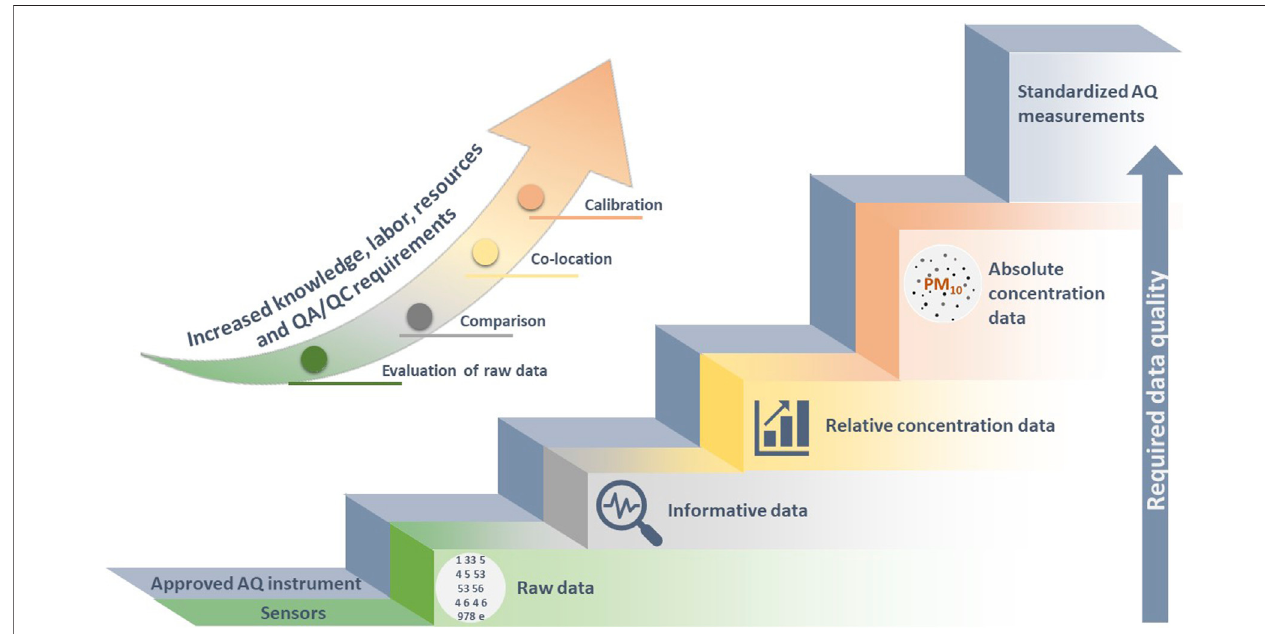
FIGURE2| Schematic ofthe QA/QC requirements, expertise requirements and required methods forapplicationofair quality measurementdata. The typical level of sensor validation and data applications are in-line with the suggestion from Peltier et al. (2021).